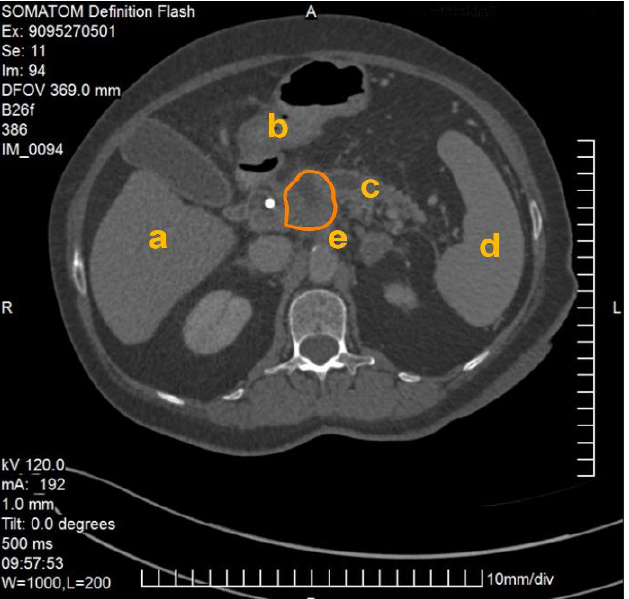
Figure 1. CT scan of a patient with locally advanced pancreatic ductal adenocarcinoma. Visible are the pancreas with a splint in the head of the pancreas as well as the liver ( a ), the gastroduodenal junction ( b ), the dilated pancreatic duct ( c ), the spleen ( d ), the abdominal aorta and the origin of the coeliac trunc ( e ). The PDAC tumor is outlined in orange.